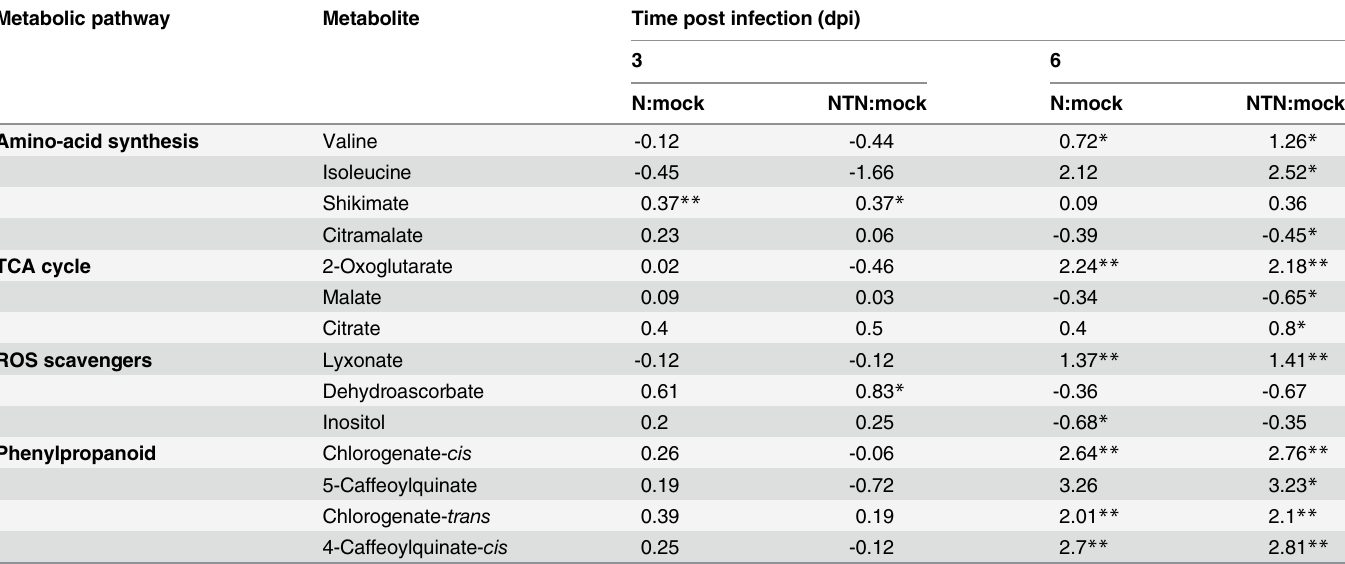
The responses in the leaves to inoculation with PVY N and PVY NTN are compared to the mock inoculation (N:mock, NTN:mock, respectively). The log2 ratios of the metabolite concentrations at the different times (i.e., 3, 6 dpi) are shown. The corresponding metabolic pathways were assigned. The statistical signi fi cances of the changes in metabolite levels were evaluated ( t